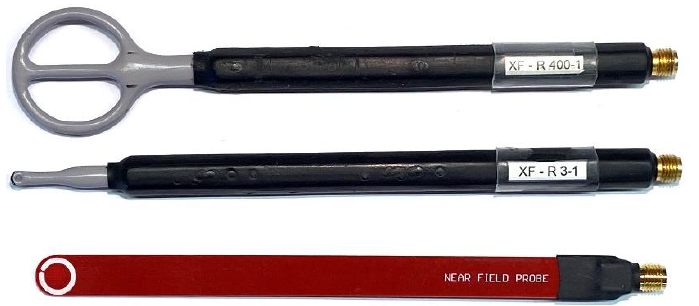
Figure 14. Photograph of designed NFP PCB and XF-R 3-1, XF-R 400-1 probes.